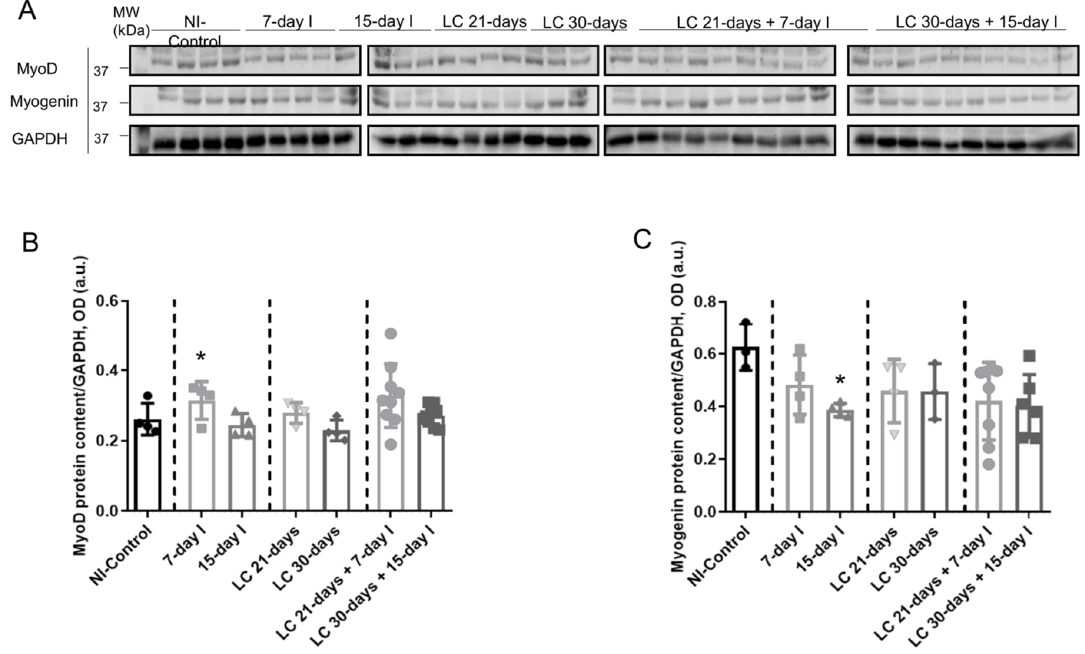
Figure 10. ( A ) Representative immunoblots of MyoD, myogenin, and GAPDH proteins in the gastrocnemius muscle of all study groups of mice. ( B ) Mean values and standard deviation of MyoD protein content in the gastrocnemius muscle of the different study groups of mice, as measured by optical densities in arbitrary units (OD, a.u.). Statistical significance is represented as follows: * p < 0.05 between 7-day I, 15-day I, LC 21-days, LC 30-days animals, and the NI-control mice; # p < 0.05 between any group of LC-cachexia mice and their respective group of mice bearing the two conditions (LC-cachexia and unloading); § p < 0.05 between any group of unloaded mice and their respective